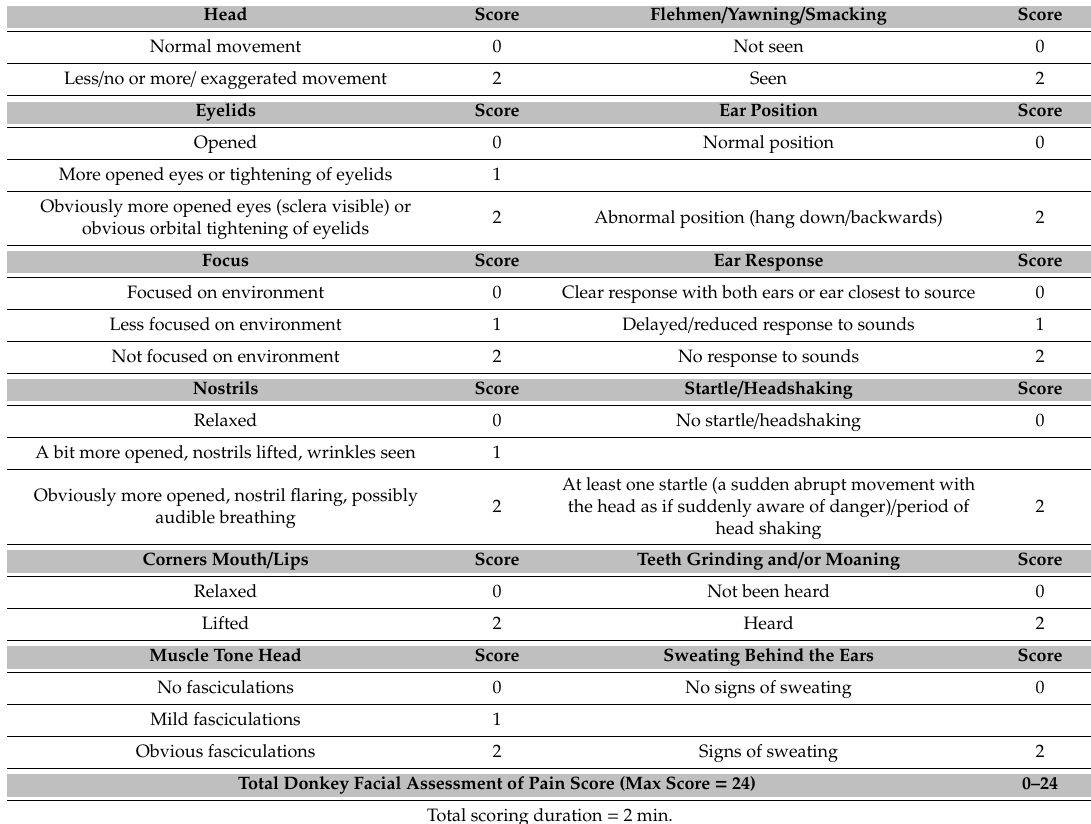
Table 3. The Equine Utrecht University Scale for Donkey Facial Assessment of Pain (EQUUS-DONKEY -FAP) score